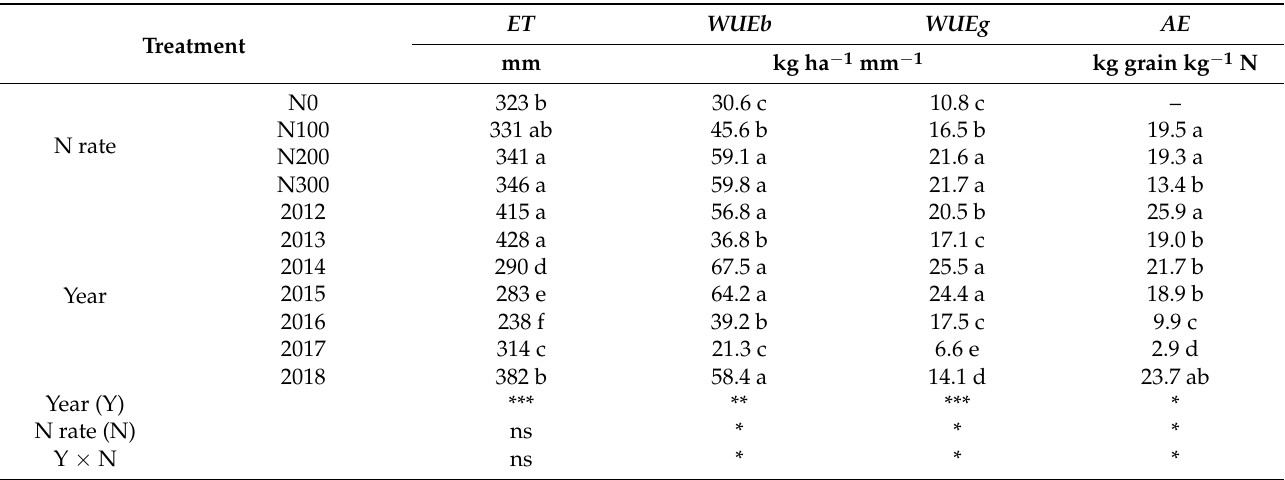
Table 4. Effects of four rates of nitrogen (N) application and growing seasons on evapotranspiration ( ET ), water use efficiency of grain yield ( WUEg ) and biomass yield ( WUEb ), and agronomic use efficiency of N fertilizer ( AE ) of